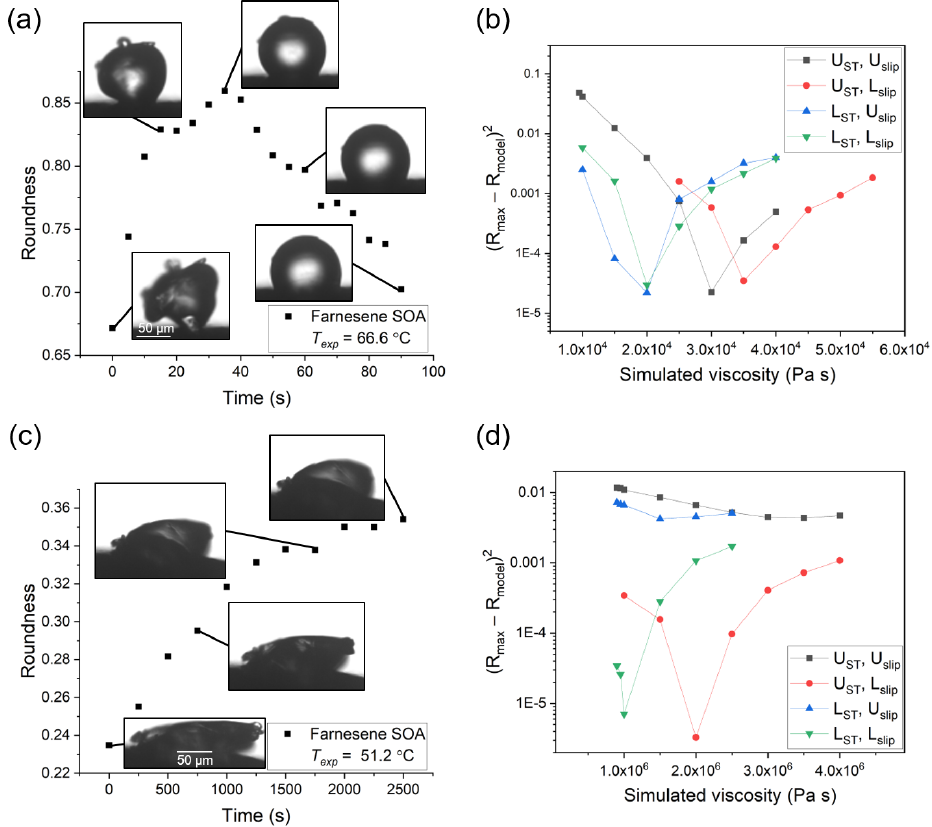
Figure 6. Hot-stage microscopy experiments with farnesene SOA material. Roundness as a function of time at (a) 66.6 ◦ C and (c) 51.2 ◦ C. The squared difference between observed and simulated roundness as a function of simulated viscosity for the two sample experiments, where panel (b) corresponds to panel (a) and panel (d) to panel (c) . The simulation that best reproduces the observation corresponds to the minimum sum of squared difference. The different colors correspond to different input combinations of surface tension and slip length used in the simulations, where U ST , U slip , L ST , and L slip correspond to the upper limit of surface tension, the upper limit of slip length, the lower limit of surface tension, and the lower limit of slip length,